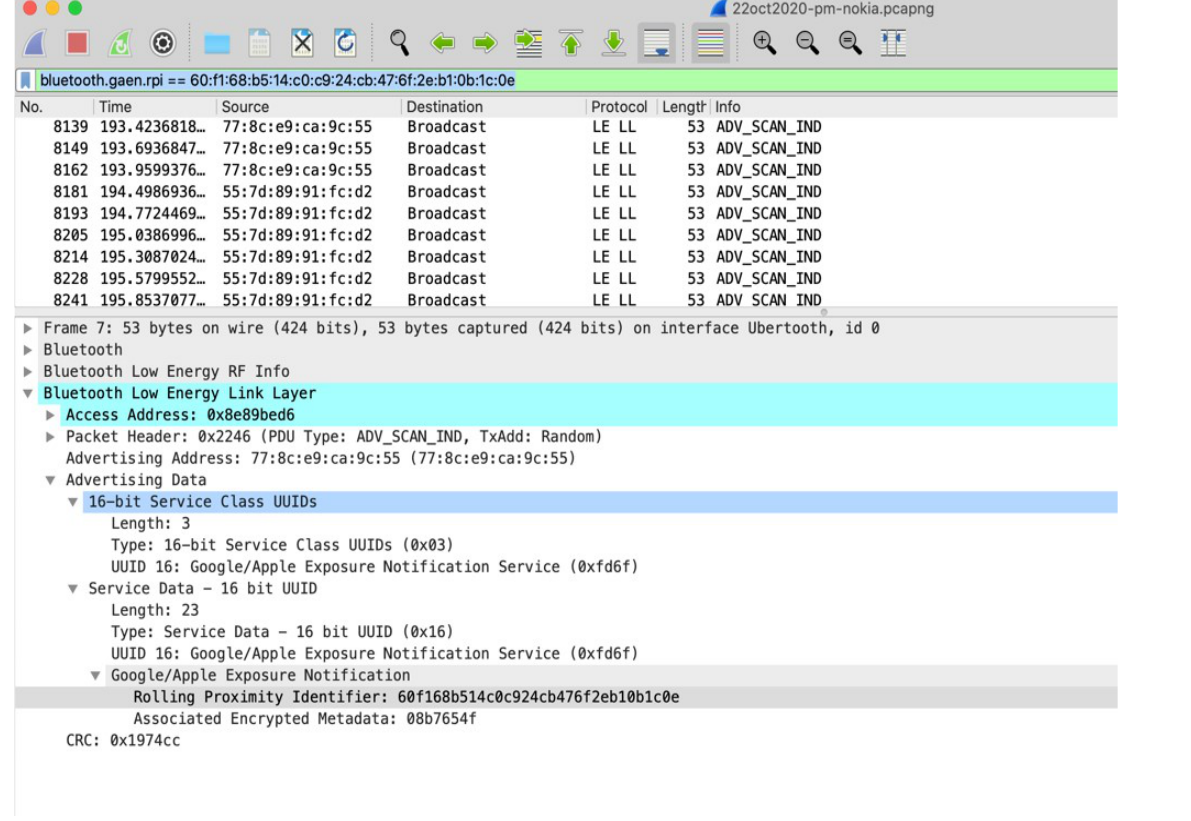
Figure 7. MAC address change with same